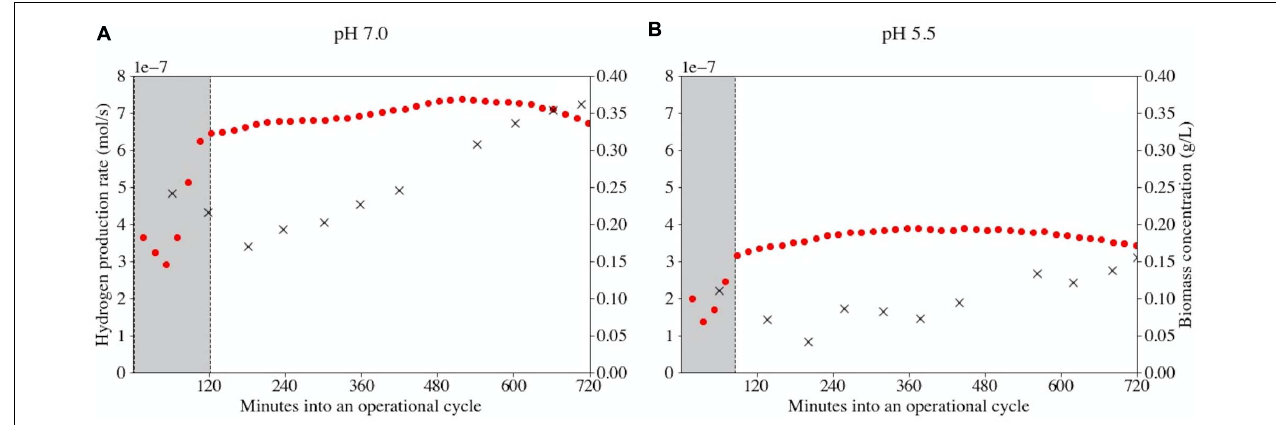
FIGURE 3 | Bioreactor-specific hydrogen production rates ( • ) and biomass concentrations ( × ) at pH 7.0 (A) and pH 5.5 (B) during operational cycle 92. The physicochemical (abiotic) behavior of the reactor was modeled in order to accurately predict the biological activity responsible for the observed gas profiles. Areas shaded in gray indicate the initiation of a new cycle and its associated uncertainty in measurements due to a temporarily changing physiochemistry. This uncertainty is mainly related to incorrect prediction of CO 2 speciation. The period of uncertainty is shorter at pH 5.5 (90 min versus 120 min) as less CO 2 dissolves at this pH.